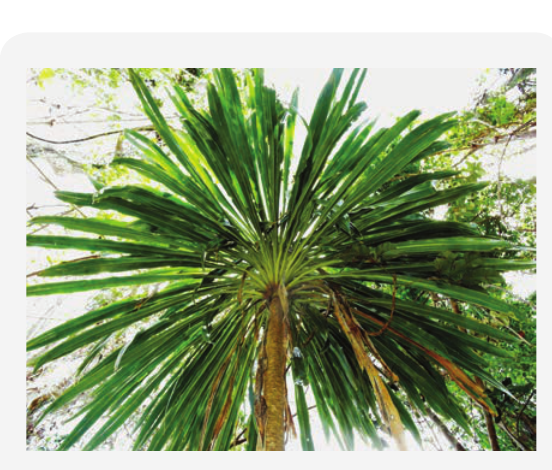
Figure 5. The growth habit of Dracaena umbraculifera. Photo by Patrice